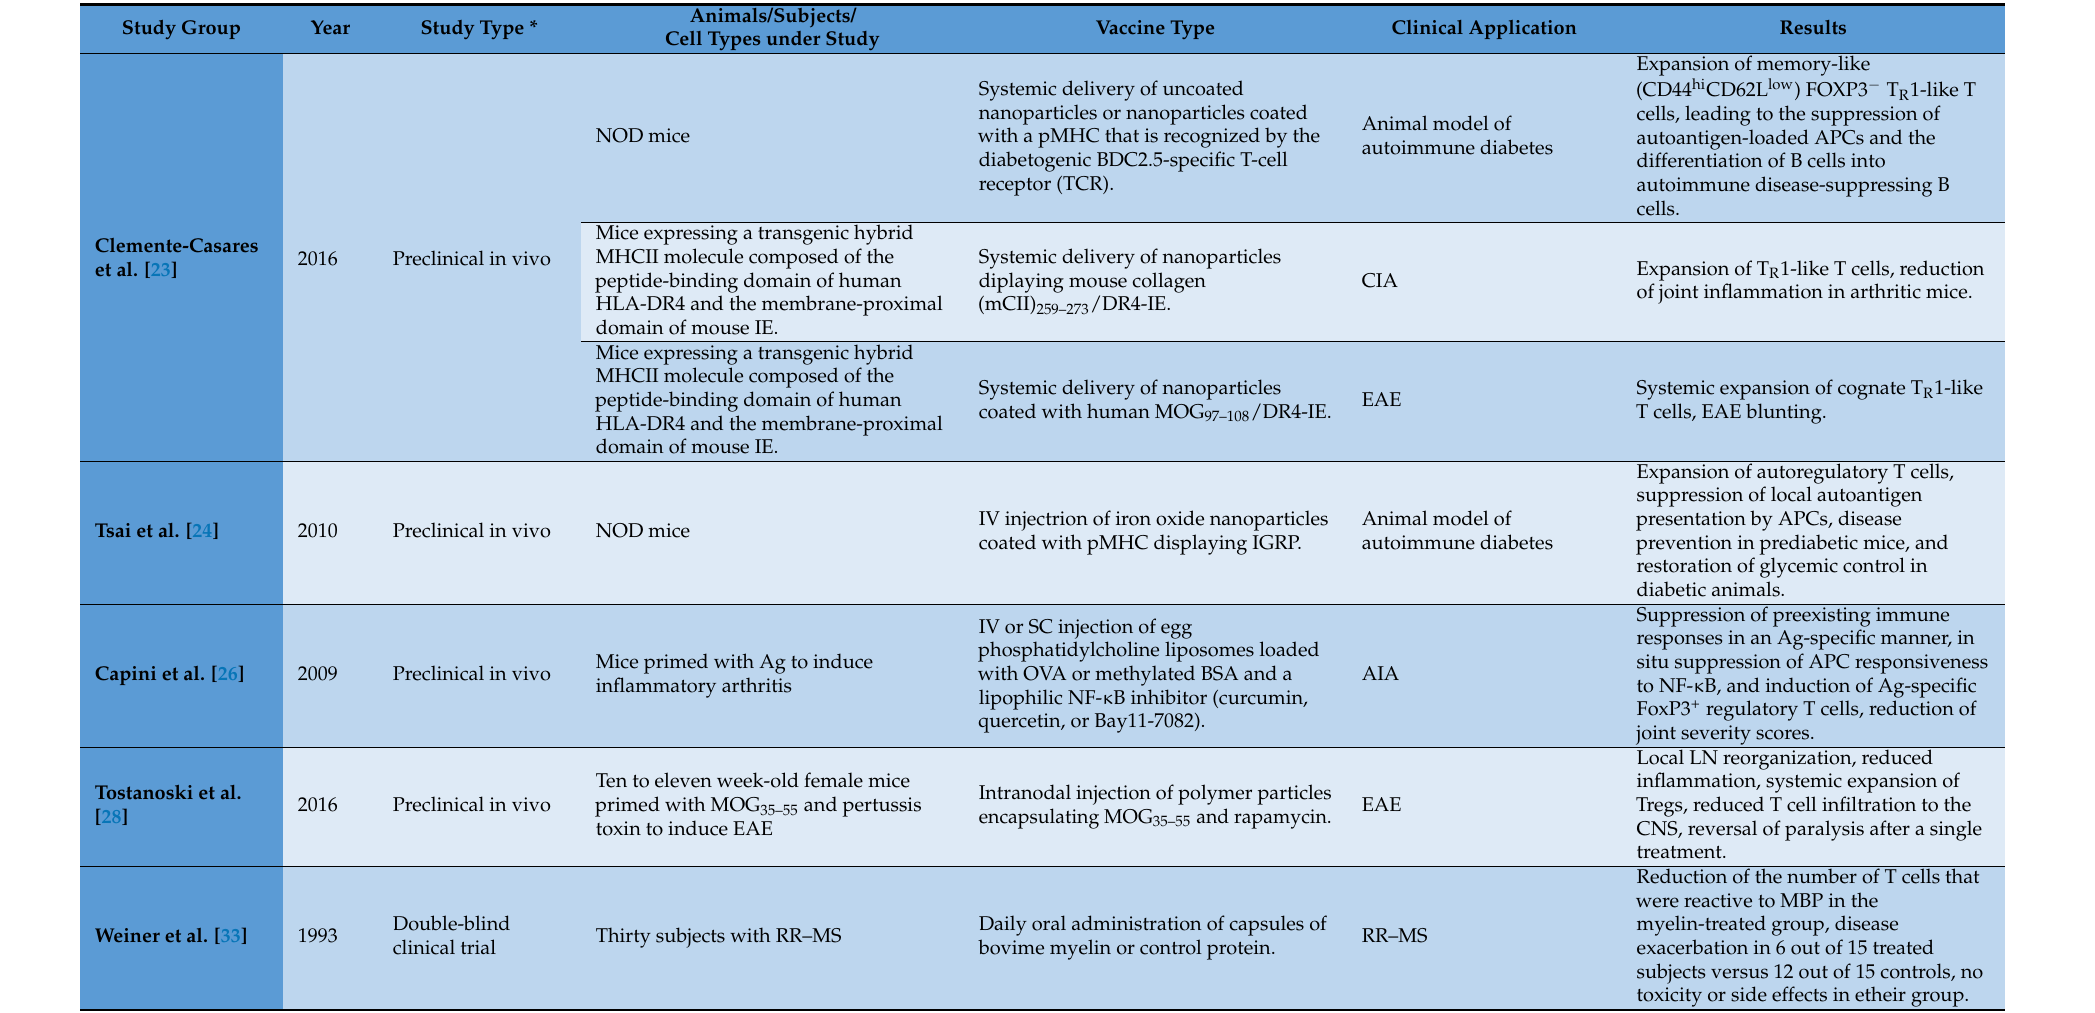
Table 2. List of the preclinical and clinical studies on tolerogenic vaccines that are cited in this review and a summary of their main characteristics and